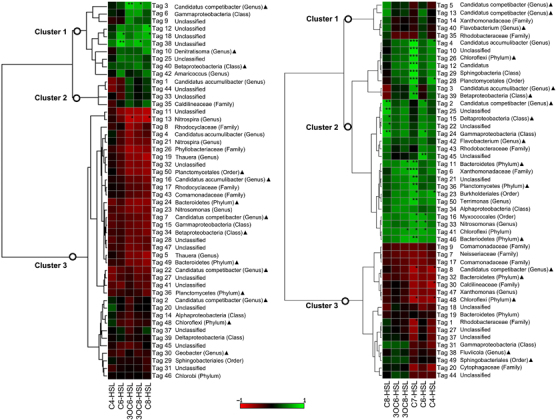
A comparison between the signalling properties of the floccular (left panel) and the granular (right panel) sludge communities. The relationships between the abundance of the top 50 most dominant community members (each represented by a unique V6 tag) and the concentration profile of N-acyl homoserine lactones (AHLs) over time were calculated based on Pearson correlation for the respective floccular and granular sludge communities. The Pearson correlation coefficient is colour coded, indicating relationships from strongly positive (+1, green) to strongly negative (−1, red) interactions. ▲Unclassified based on the taxonomy classification pipeline stated in Materials and methods section. The closest relative with sequence identity matching >97% is shown where it is applicable. False discovery rate corrections for multiple comparisons were performed, and significant differences are indicated as follows: *P<0.05, **P<0.01 and ***P<0.001. The signalling properties of the granular sludge community was adapted from Tan et al.19